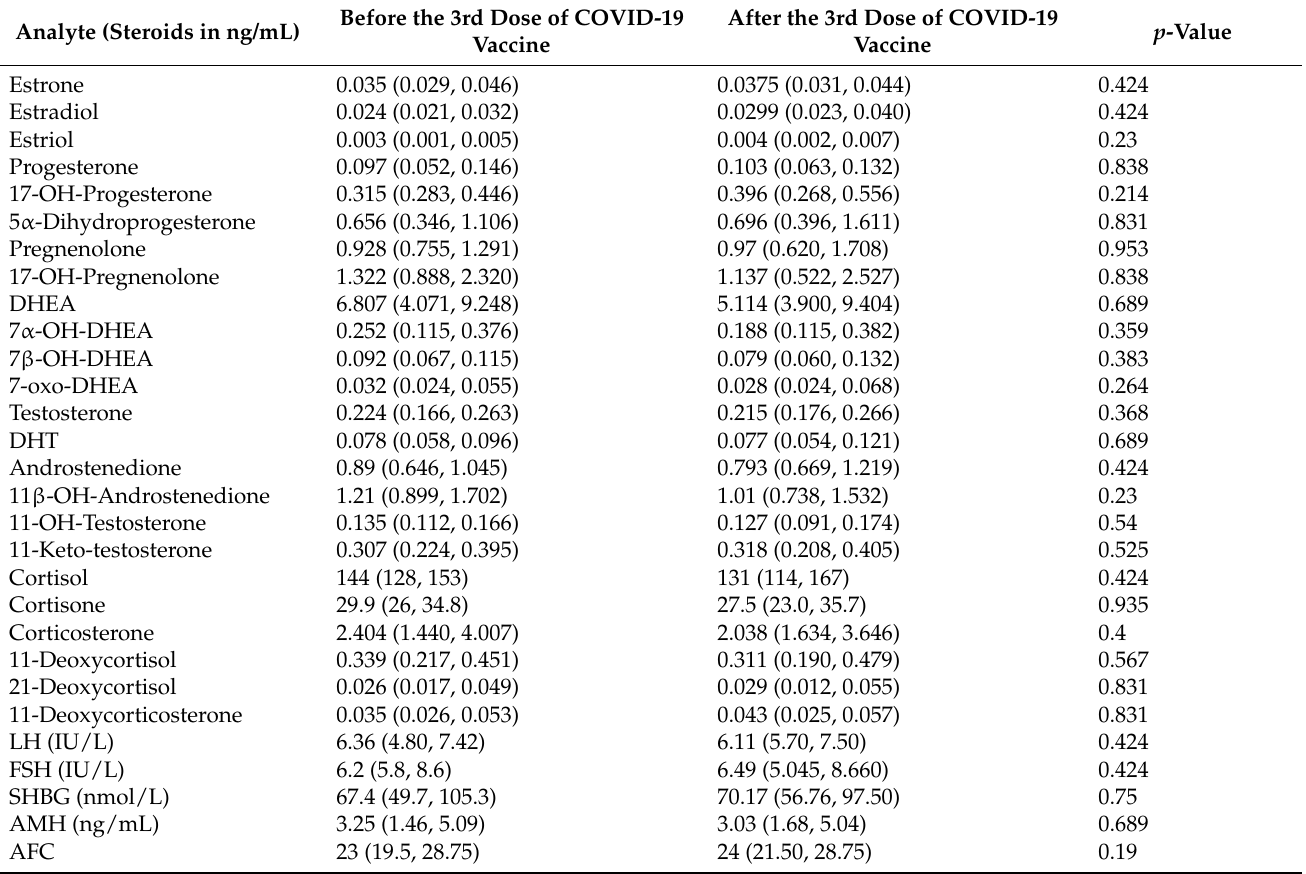
Table 2. The levels of steroids, LH, FSH, SHBG, AMH and AFC in plasma/serum of women before and 2–4 months after 3rd dose of COVID-19 vaccination. Medians with lower and upper quartiles (in parentheses) are given. p -value indicates statistical significance; no significant differences were found for any of the